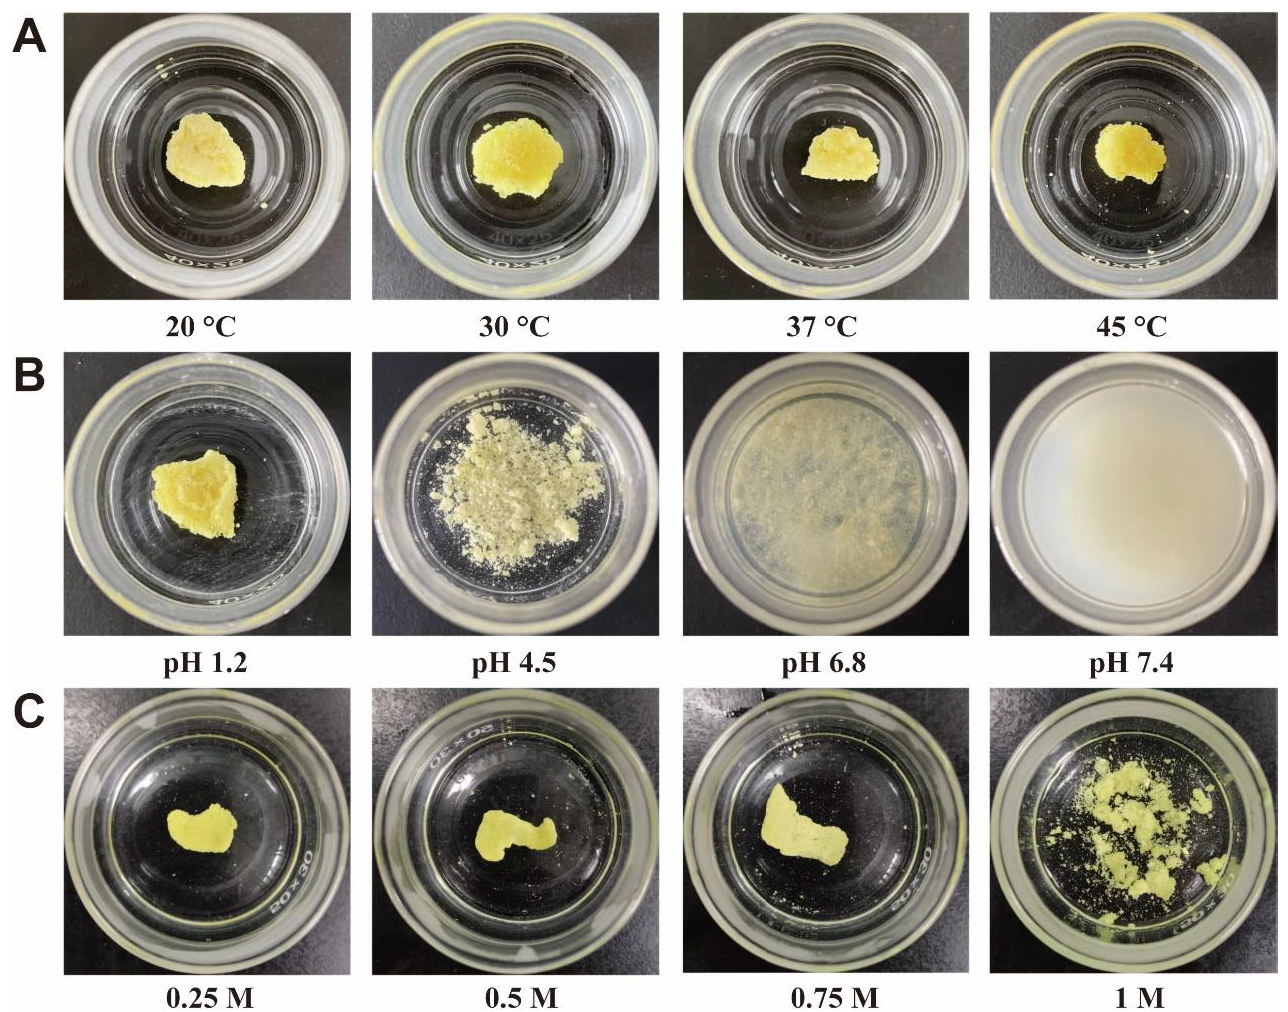
Figure 6. Images of amorphous ACM in a beaker after dissolution in aqueous solutions at different ( A ) temperatures, ( B ) pH values, and ( C ) ionic strengths.